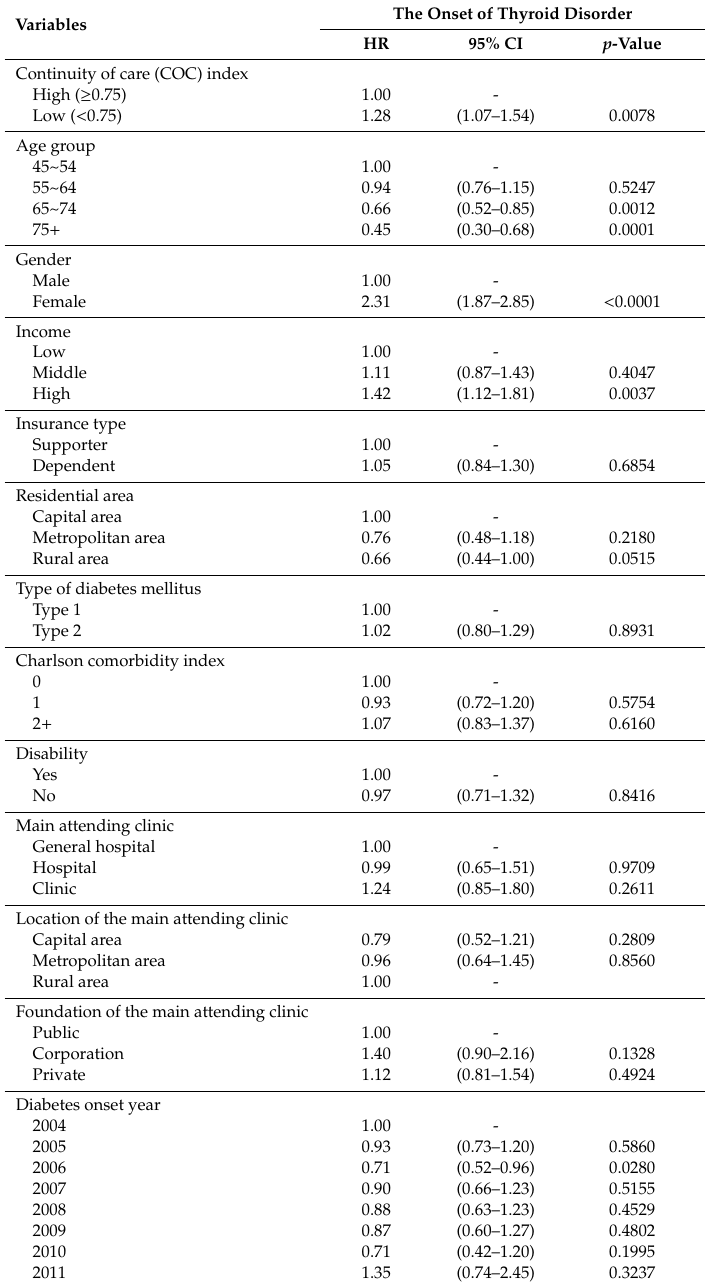
Table 2. The factors associated with the onset of thyroid disorder among diabetes mellitus patients by cox proportional hazard regression.